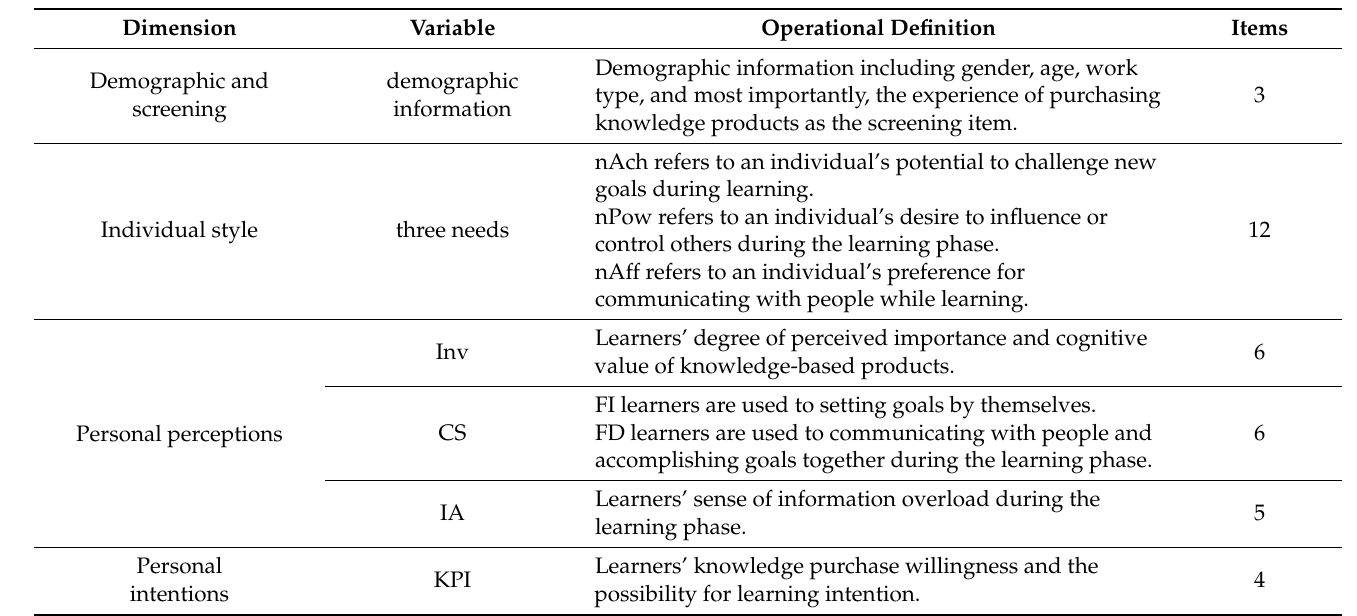
Table 1. The operational definition of all dimensions.